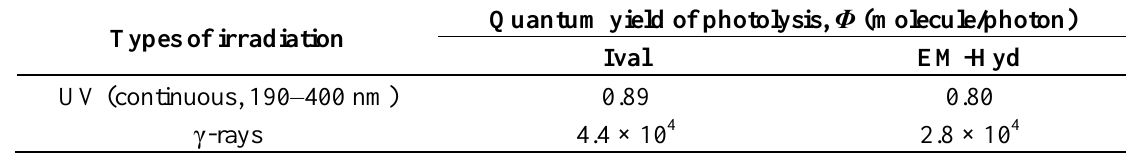
Table 2. Quantum yield values ( Φ ) for photolysis of Ival and